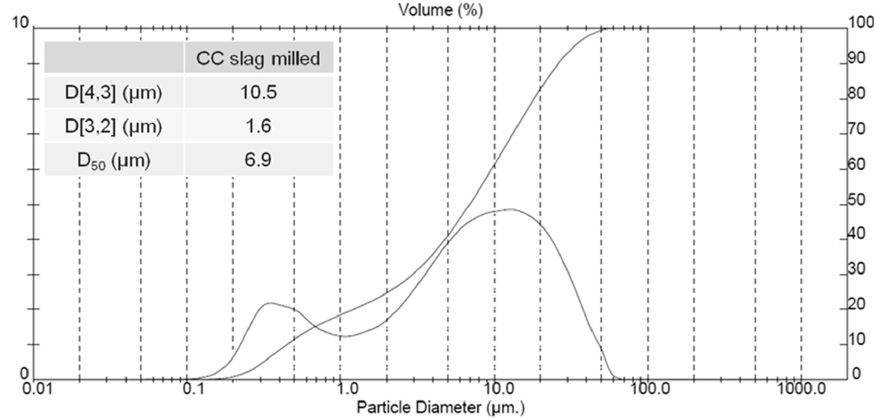
Figure 9. Particle size distribution of micronized CC slag, determined by laser diffraction [39].